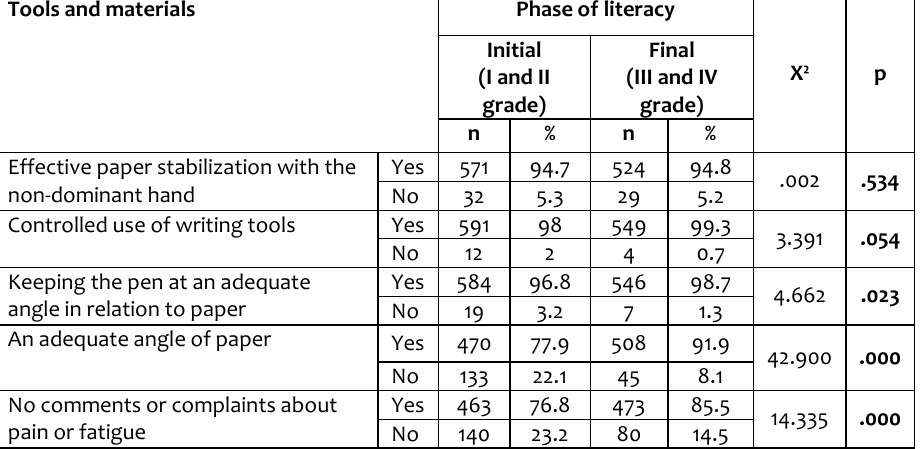
Phase of literacy Final Initial (III and IV (I and II grade) grade)